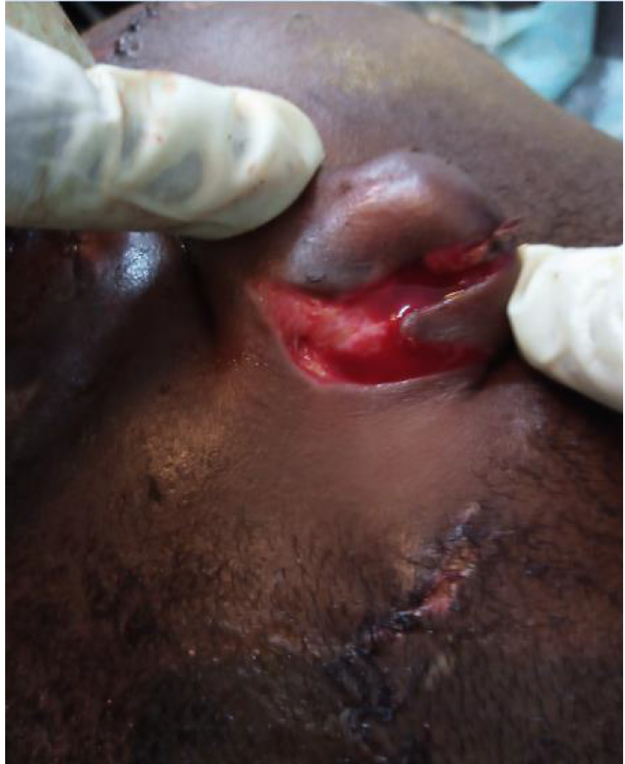
Fig. 2. Decay of the pavilion exposing the cartilage.